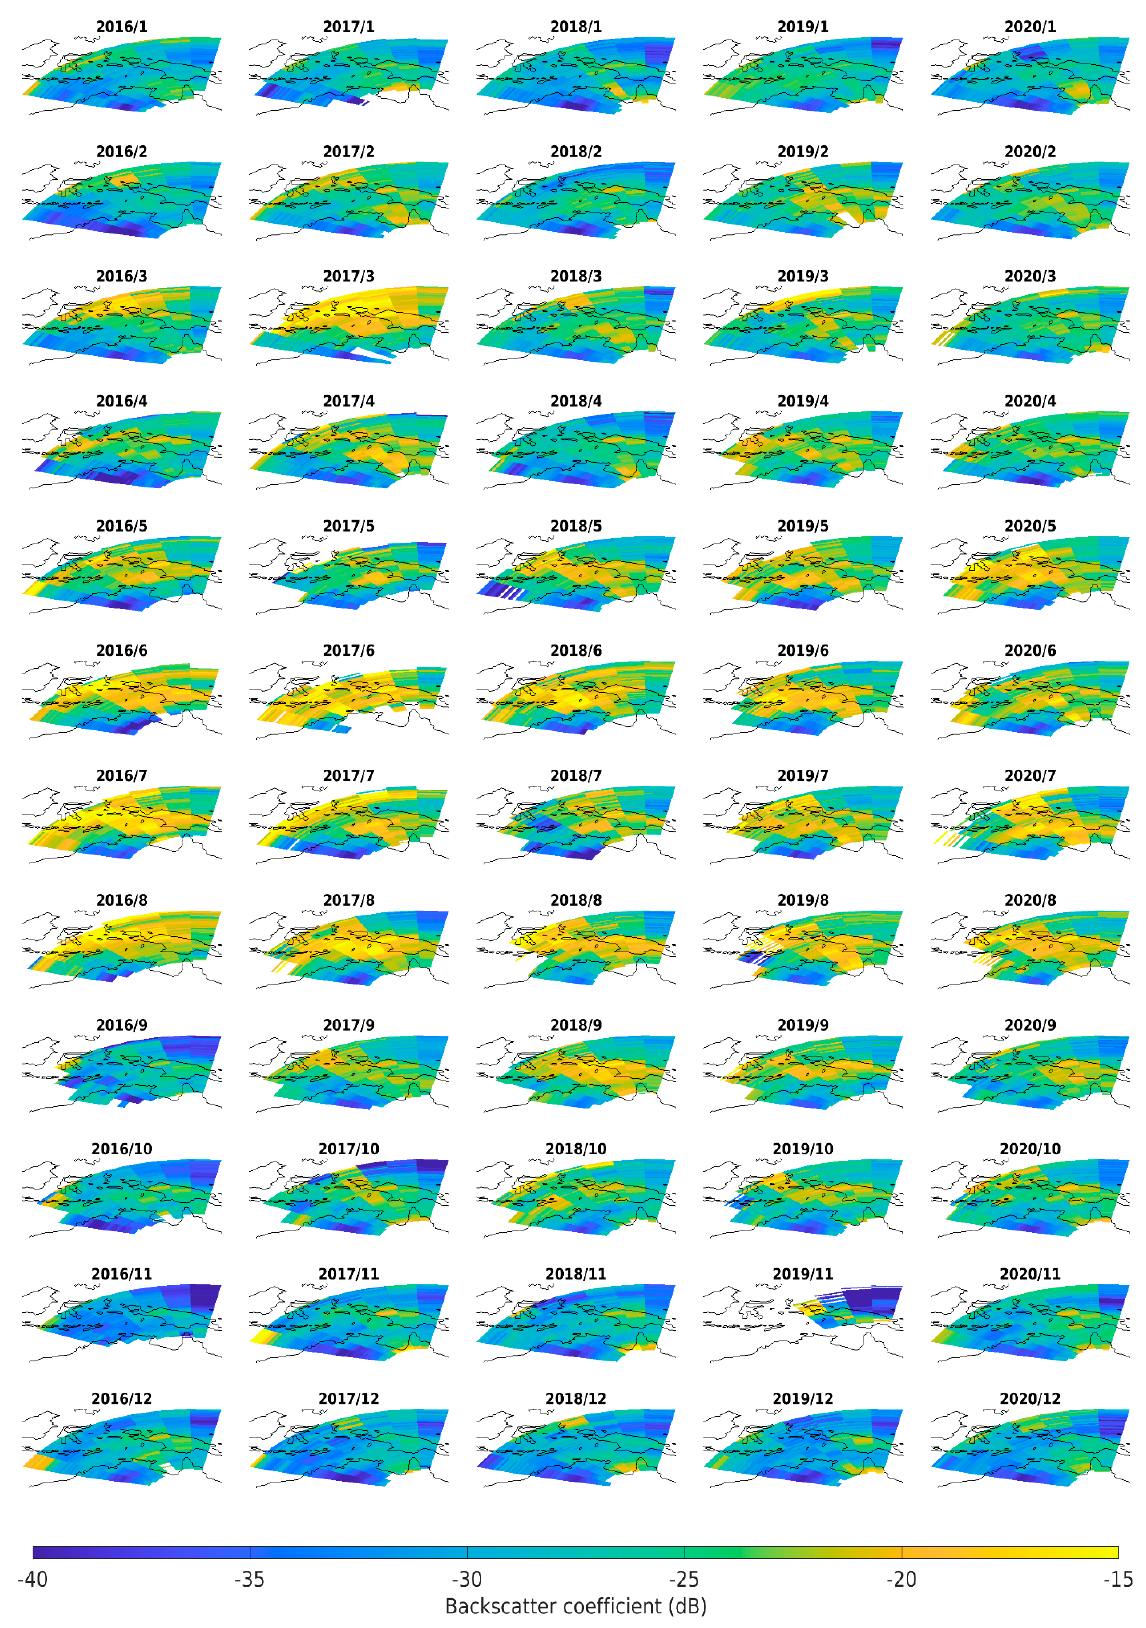
Figure 5. Monthly mean backscatter coefficients for LO over a 5 year period from January 2016 ( top left plot ) through to December 2020 ( bottom right plot ).